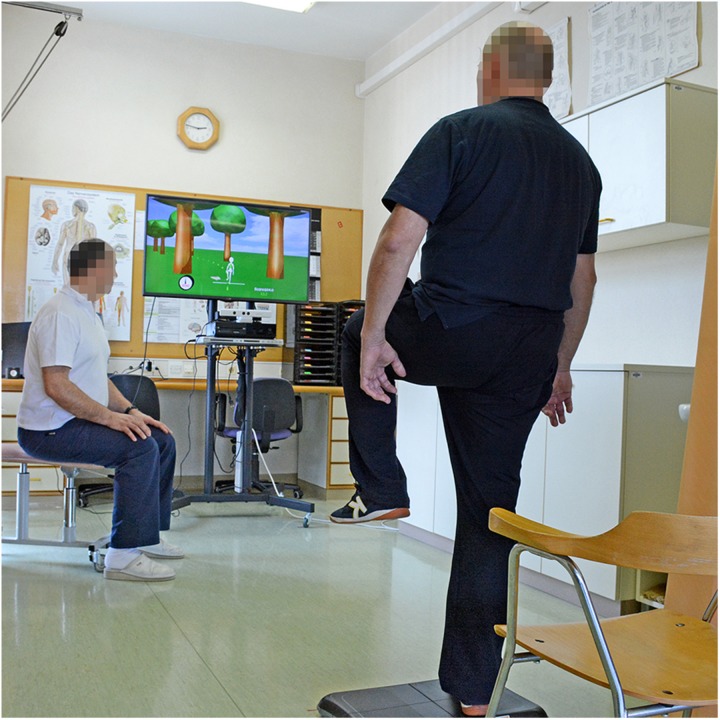
Setup for the exergaming. The participants were standing on the Wii Balance board and played 3 different games. MS Kinect camera tracked the participants’ movements.